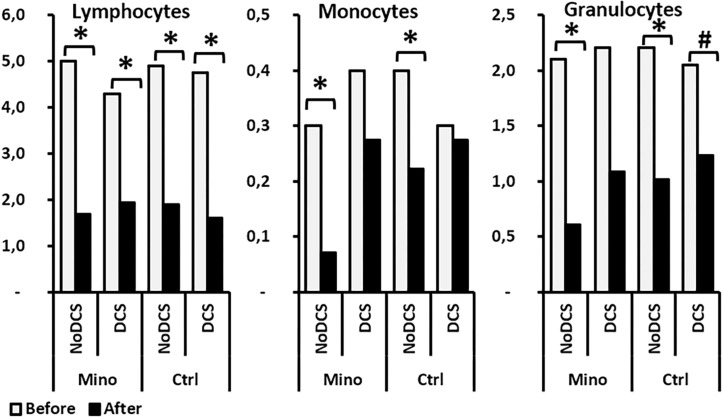
Effects of Minocycline on white blood cells count before and after the hyperbaric exposure, according to the clinical status and the treatment. As results showed haemoconcentration linked to the hyperbaric exposure, the blood parameters registered after the dive were corrected individually depending on the variation in the haematocrit. *Notes significant difference (p < 0.05) between before and after the dive for the same parameter, and # denotes p < 0.10 (trend) between groups. Ctrl, Control mice (no active molecules, white blocks); Mino, Minocycline (90 mg/kg, gray blocks).